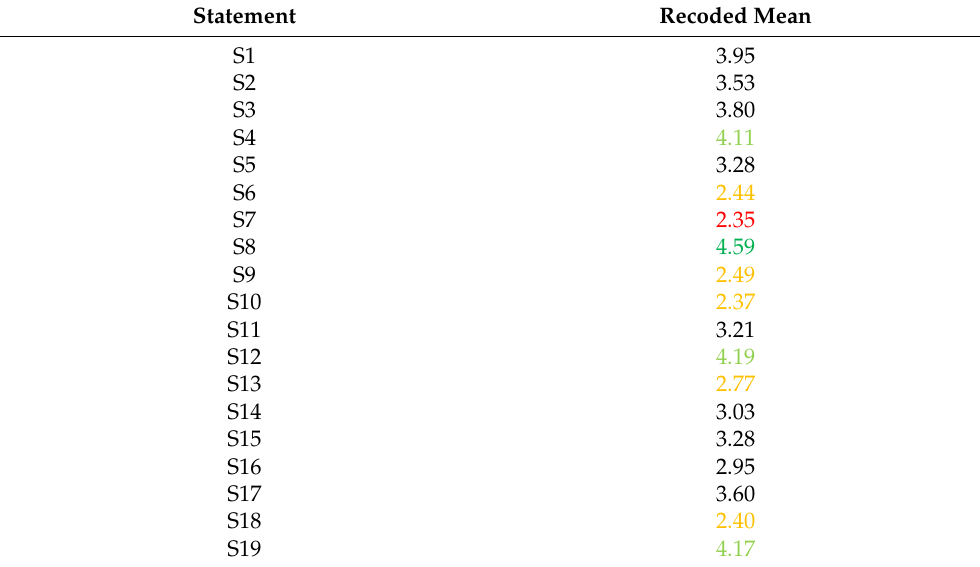
Table 3. Recorded response